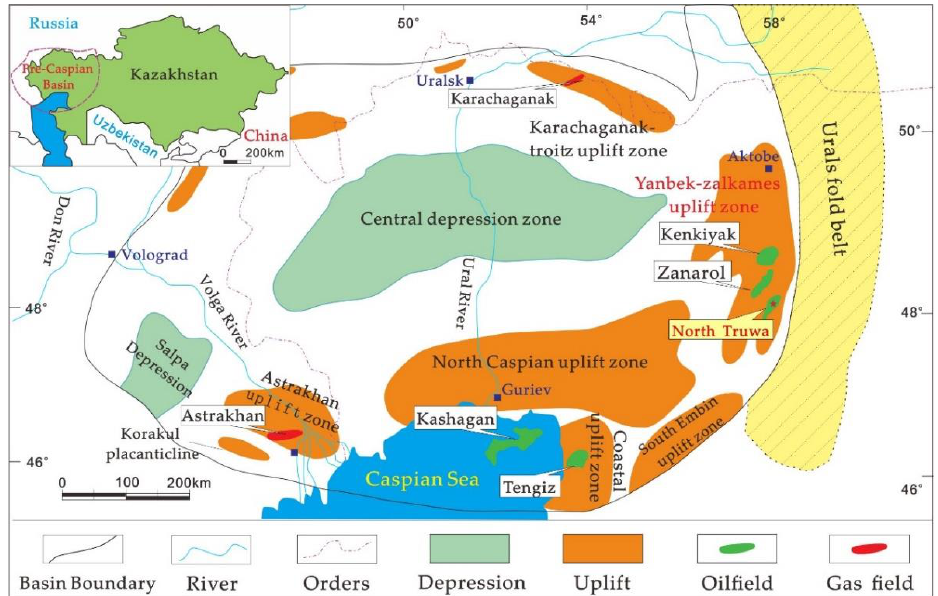
Figure 1. A map for the division of structural units in the Pre-Caspian Basin and the location of the North Truva oilfield.